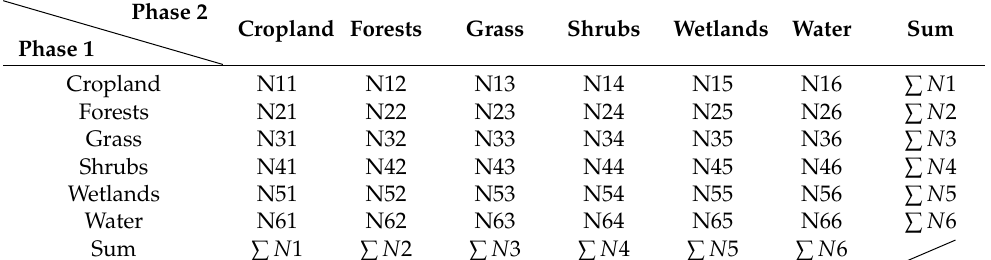
Table 3. Conversion matrix of the land cover type of each eco–geographical